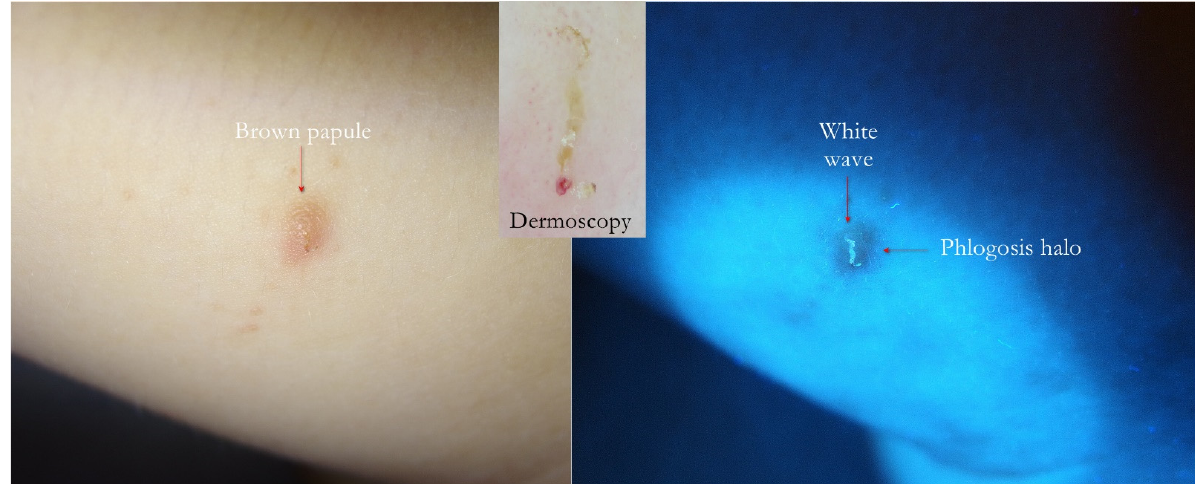
Figure 8. Flash light vs. UVA. Papular scabies. A generic brown infiltrative lesion on inner side of thigh ( left ) produced a wavy linear luminescence under UVA ( right ). In the upward inset, dermatoscopy showed that the white wave was a MGU housed in the papule darker than the background.